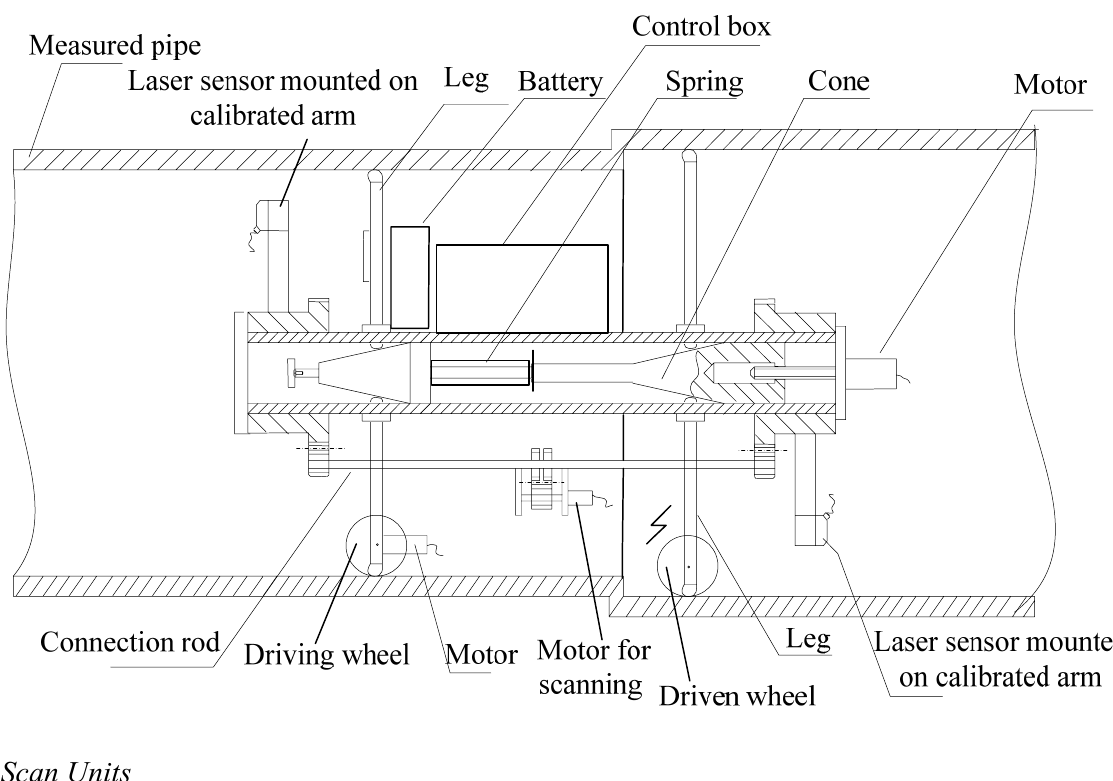
Figure 1. Mechanical structure of the proposed measurement